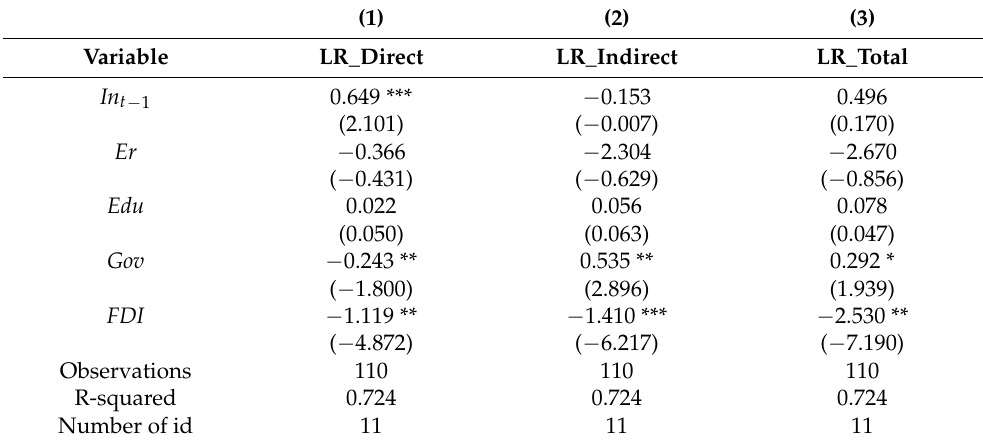
Table 8. Estimates for western